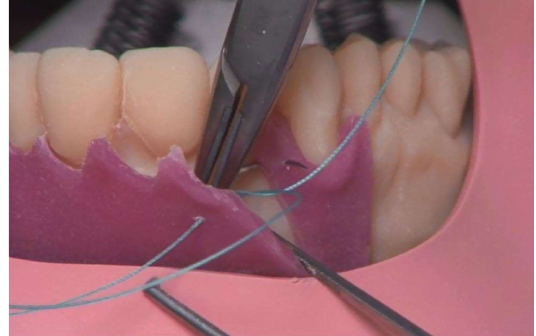
Figure 10. Suture exercise on the gingiva mask.